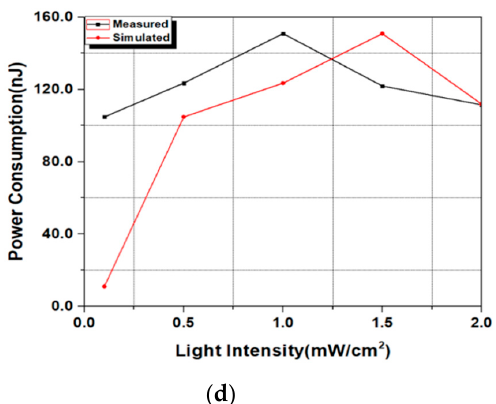
Figure 9. ( a ) Experimental investigation at the interface between wireless power devices and CMOS neuron IC, ( b ) retinal image acquisition where magnitude of read-out spikes is 50 mV, ( c ) retinal image acquisition where magnitude of read-out spikes is 110 mV, and ( d ) power consumption. Table 2. Comparison performance of current work with reported ones.